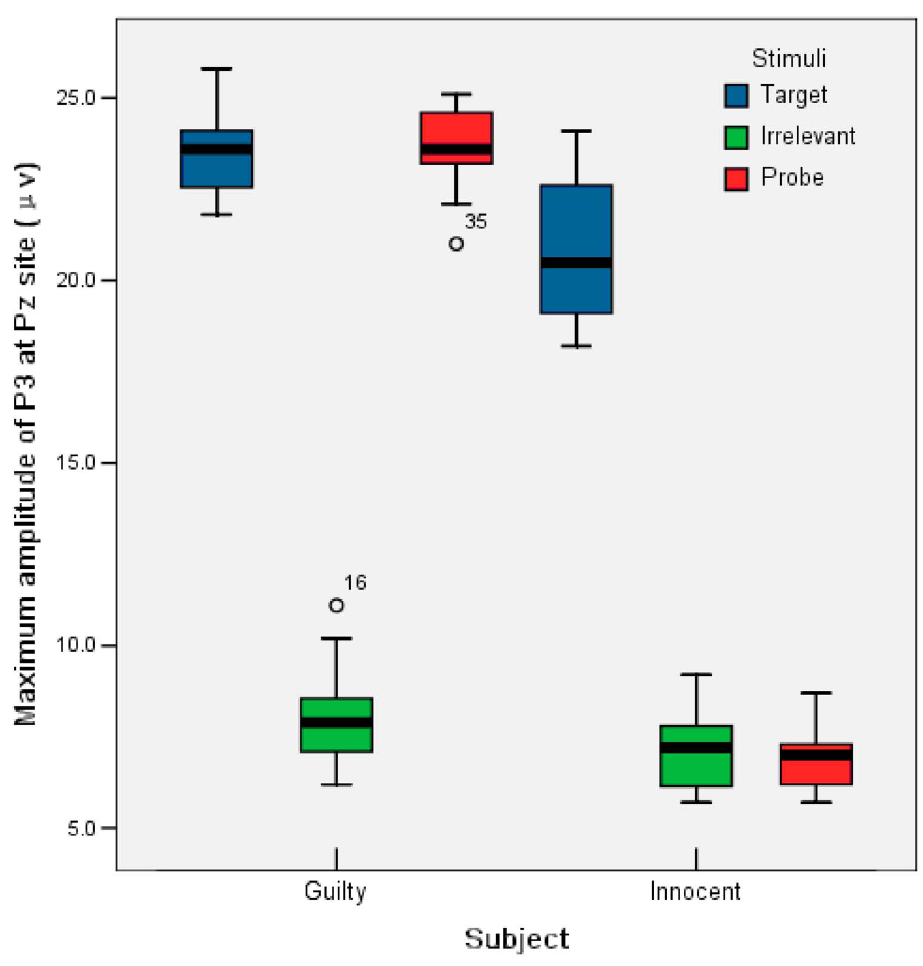
Figure 5. Boxplot of the maximum amplitude of P300 at Pz in different stimuli and subject groups.